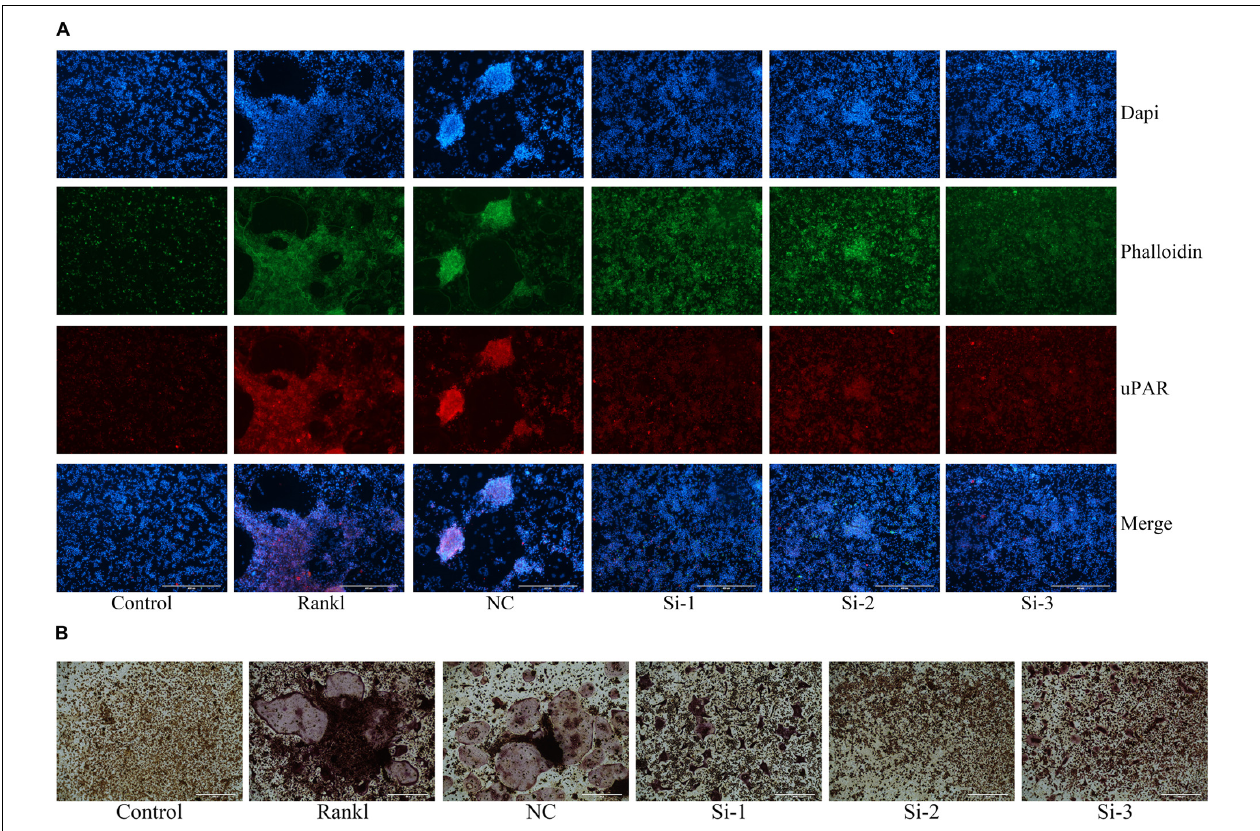
FIGURE 7 | Knockdown of uPAR decreased RANKL-induced osteoclast and actin ring formation. NC represents siRNA negative control, Si-1, Si-2, and Si-3 represent siRNAs that silence three different fragment of uPAR. BMMs were seeded in 96-well plates and transfected with three siRNAs and NC siRNA, respectively, and cultured with M-CSF (30 ng/mL) and RANKL (50 ng/mL) for 5 days. (A) Immunofluorescence and (B) TRAP staining was performed then. The experiment was performed three times